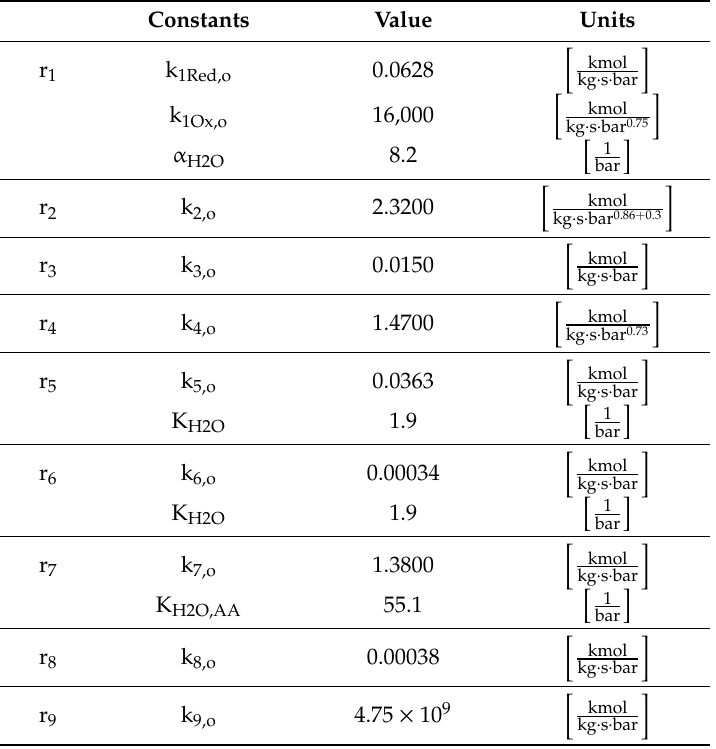
Table A1. Experimental parameters for the rate law of acrolein formation